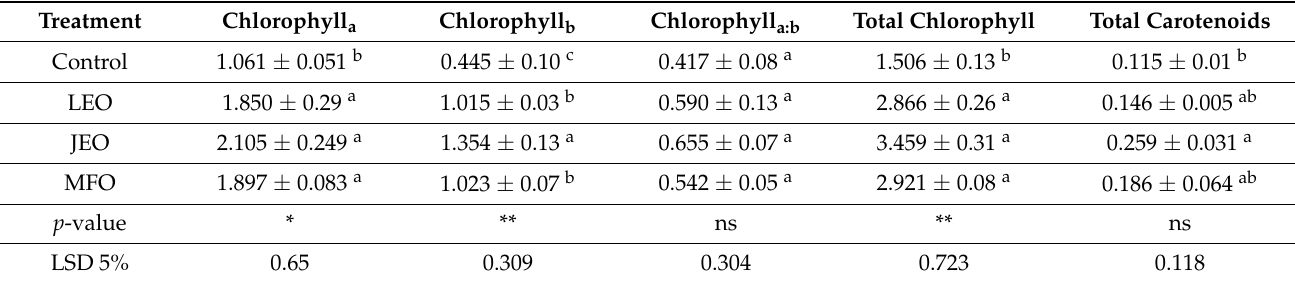
Table 3. The effect of foliar application with jasmine and lavender essential oils or mustard fixed oil on photosynthetic pigments (mg/g FW) of eggplant growth under TSSM natural infestation in a controlled